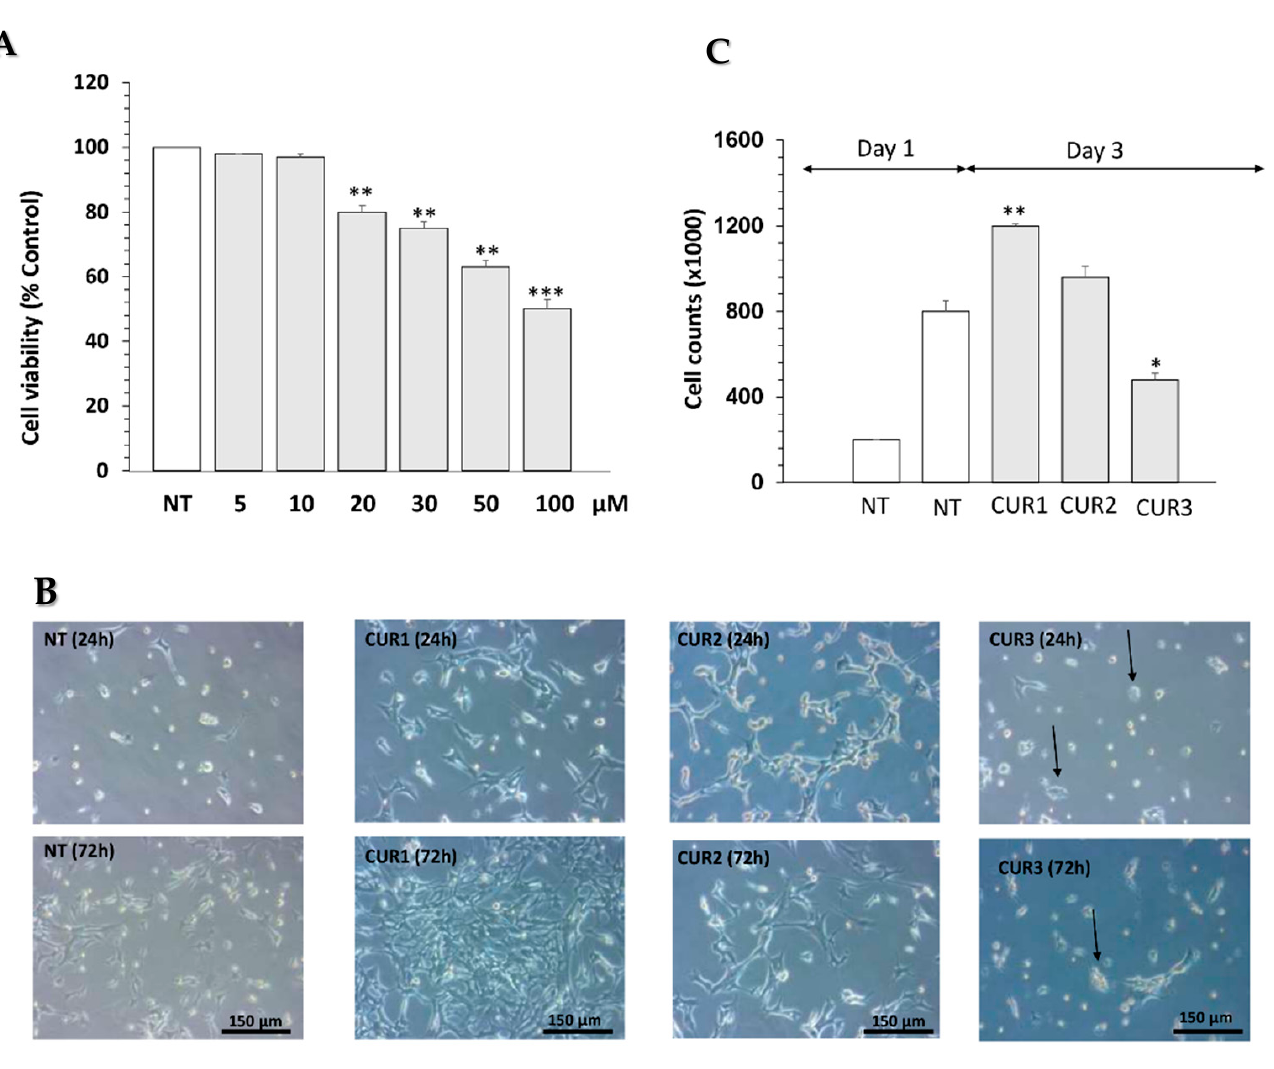
Figure 1. Effect of curcumin on cell viability and proliferation of astrocyte C8-D1A cells. ( A )